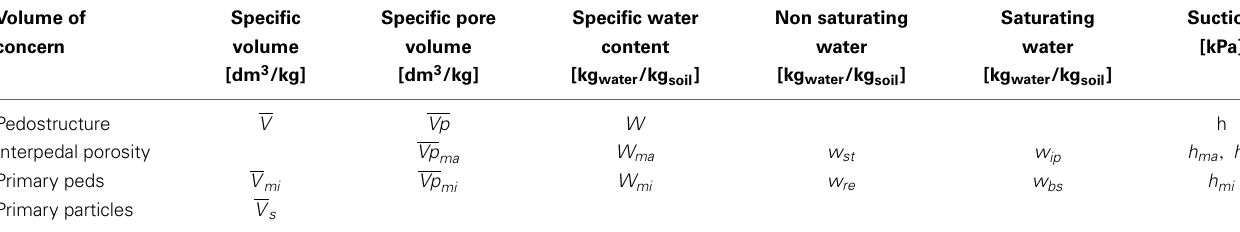
Table 1 | Pedostructure state variables.